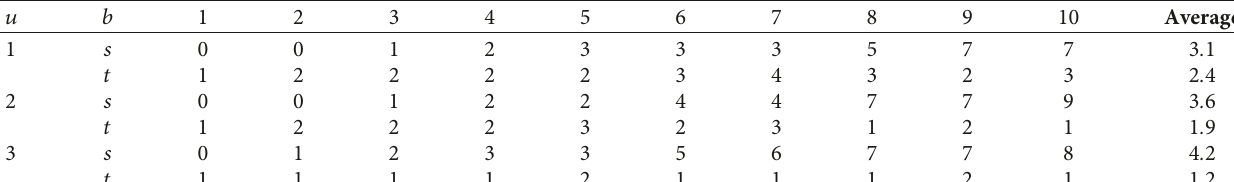
Figure 9: Relative cost reduction with an increasing budget. Comparison between fortifications only, expansions only, and both. Table 4: Best budget distribution between fortifications and expansions.